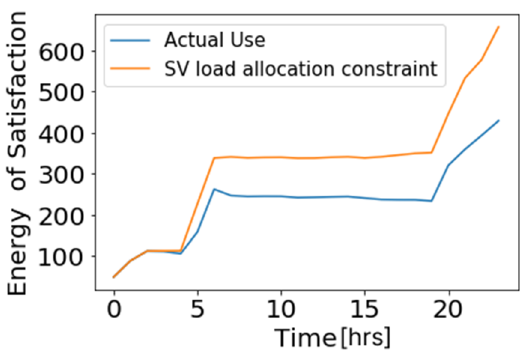
Figure 8. ES Satisfaction with the proposed SV load allocation using the same or less energy than real REDD [31] database vs. real usage according to the REDD [31] database.